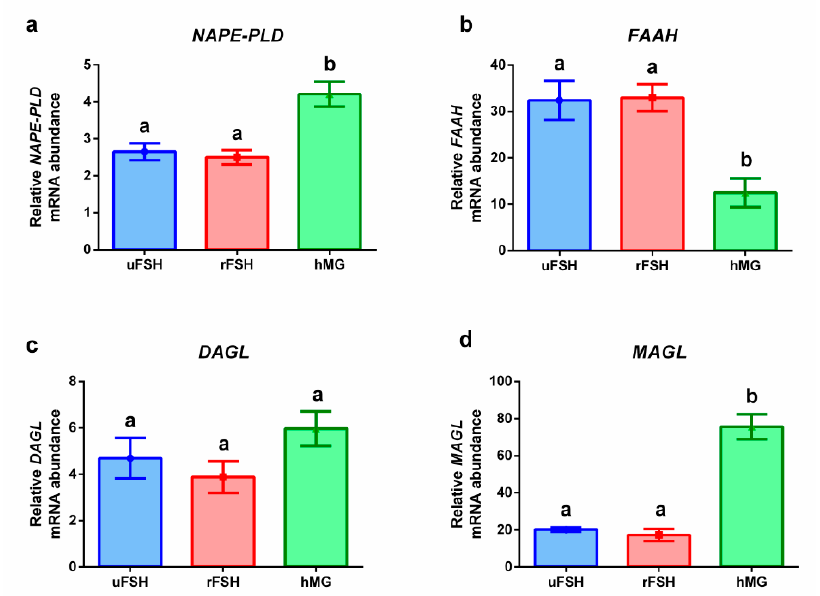
Figure 2. Gene expression profiles: ( a ) NAPE-PLD : N-acyl phosphatidylethanolamine phospholipase D; ( b ) FAAH : fatty acid amide hydrolase; ( c ) DAGL : diacylglycerol lipase alpha / beta; ( d ) MAGL : monoglyceride lypase. Results are reported as mean ± standard deviation. Statistical significance was set at p < 0.05 and calculated by One Way ANOVA followed by Tukey’s multiple comparisons test. Different letters above columns indicate statistical differences among